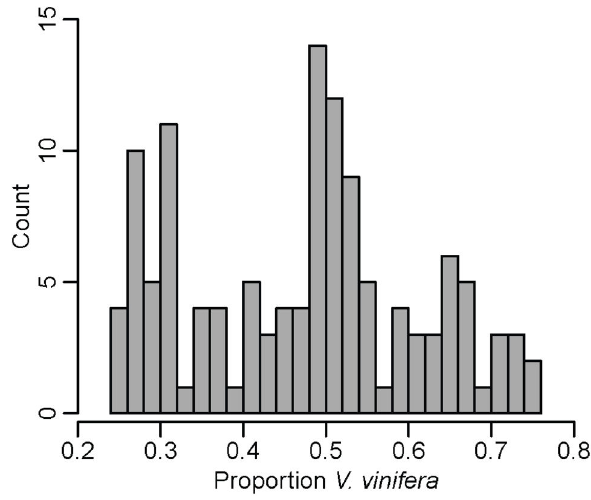
Figure 3. Estimated V. vinifera content in grape hybrids. The distribution of V. vinifera ancestry proportions in 127 hybrids from the USDA germplasm repository. Estimates are based on the full set of 2959 SNPs. A table of cultivar names, information and proportion V. vinifera ancestry is provided in Table